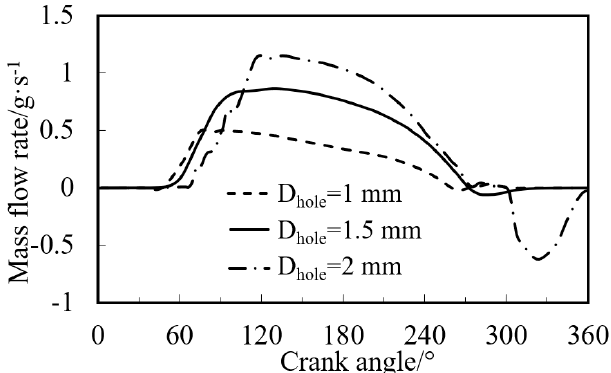
Figure 11. Variations of mass-flow rate in the liquid-return hole with the crank angle.